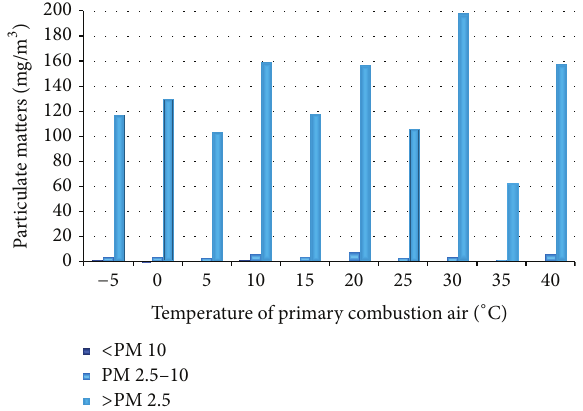
Figure 7: Concentrations of particulate matter for different temper- atures of air.